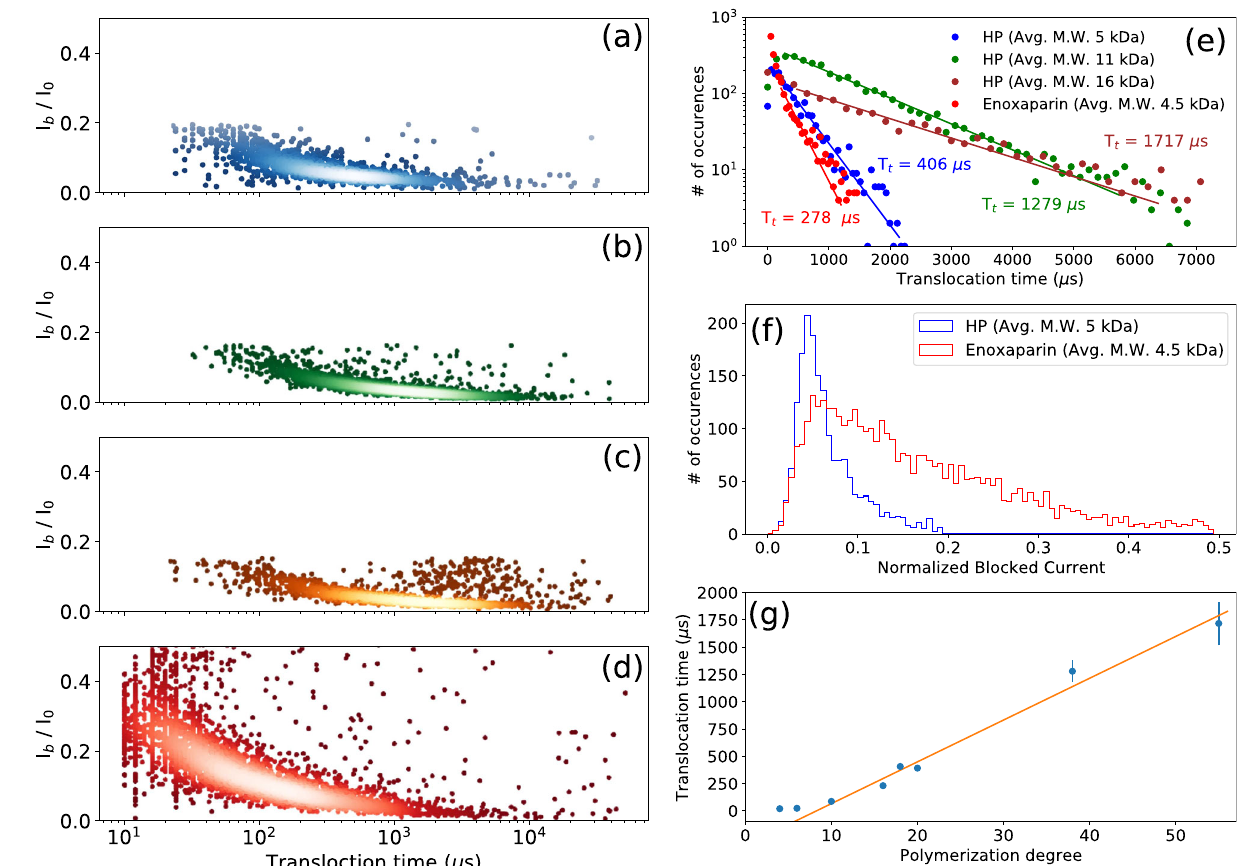
Fig. 3 | Investigation of size discrimination of heparin polysaccharides using AeL nanopore. Scatter plots derived from HP polysaccharides with the average molecular weights of a 5kDa, b 11kDa and c 16kDa; and d of enoxaparin with the average molecular weight of 4.5kDa. e Superimposed translocation time histo- grams corresponding to a – d scatter plots. Distinct translocation times are observedforthreedifferentsizesofHPpolysaccharides.Enoxaparindistributionis clearly not mono-exponential contrarly to other samples. The timescales resulting frommono-exponential fi tsare406±15 µ s,1279±30 µ s,1717±73 µ sand278±24 µ s for HP 5kDa (dp18), HP 11kDa (dp38), HP 16kDa (dp55) and enoxaparin, respec- tively. f Superimposed I b histograms corresponding to a , d scatter plots.